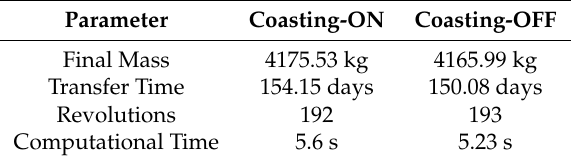
Table 3. Algorithm performance comparison for coasting ON/OFF modes for Super-GTO to GEO